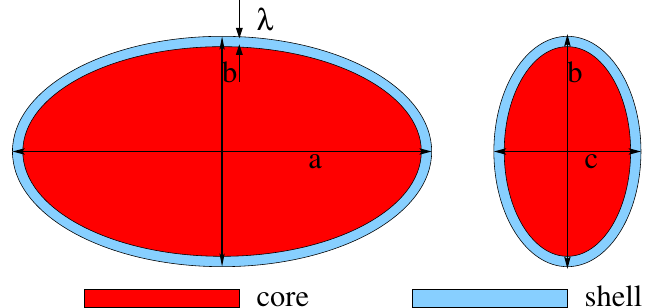
Figure 2. Scaled representation of an ellipsoidal cocoa bean (core and shell). a , b and c are the three principal axes and λ is the shell thickness.